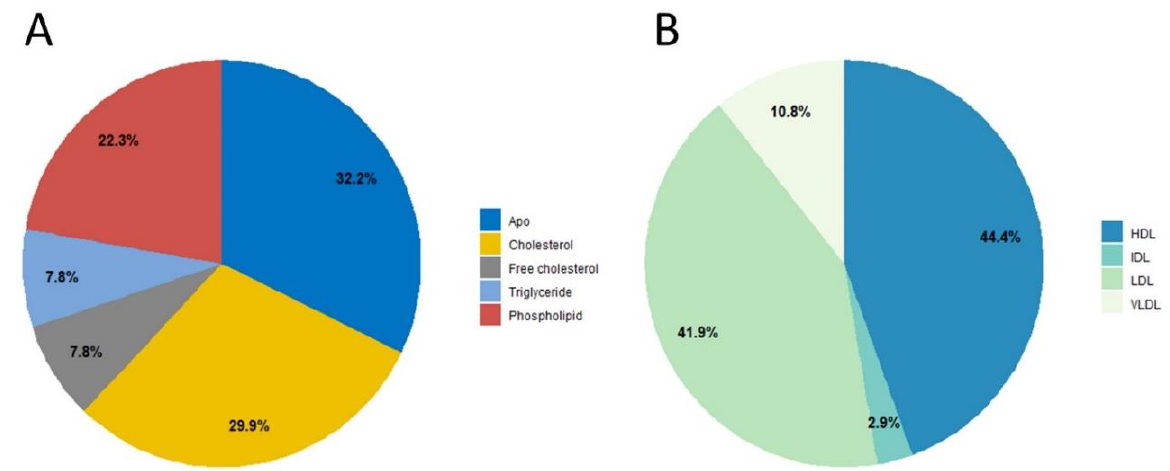
Figure 1. Relative concentration (%) of lipoproteins and lipids ( A ) and lipid main fractions ( B ) in the study cohort comprising 844 heathy blood donors (661 men + 183 women). Very low-density lipoprotein (VLDL), low-density lipoprotein (LDL), intermediate-density lipoprotein (IDL), and high-density lipoprotein (HDL).